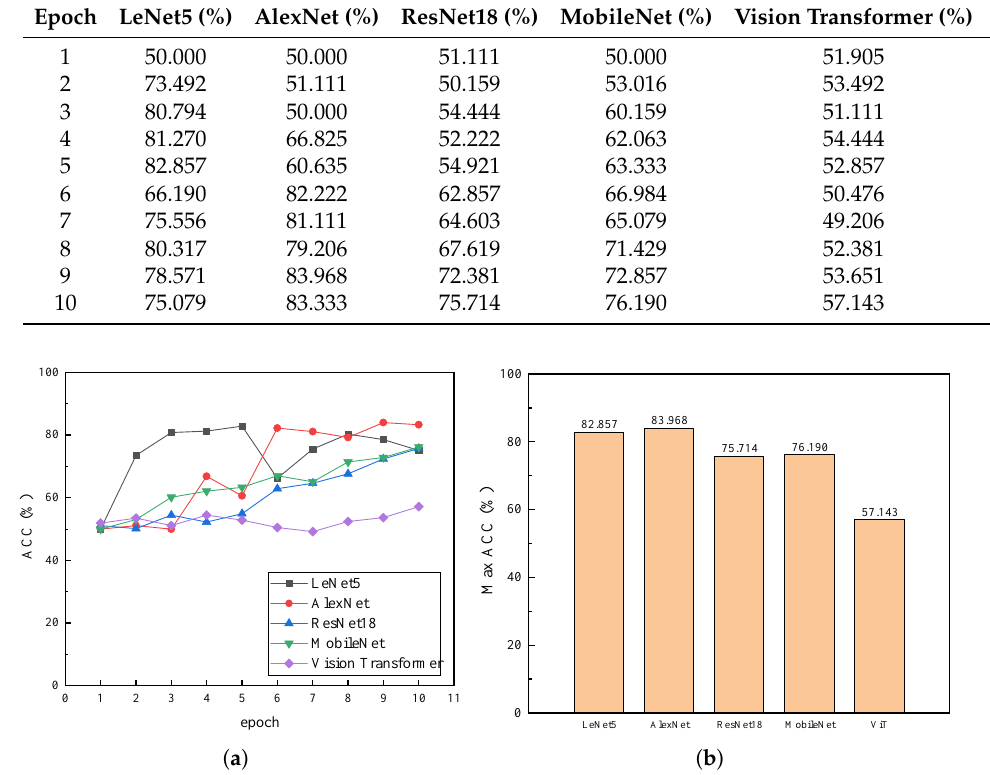
Figure 8. Comparison of accuracy after data augmentation and before GPU loading. ( a ) Comparison of accuracy of each model after data augmentation and before GPU loading. ( b ) Histogram comparing the highest accuracy of each model after data augmentation and before GPU